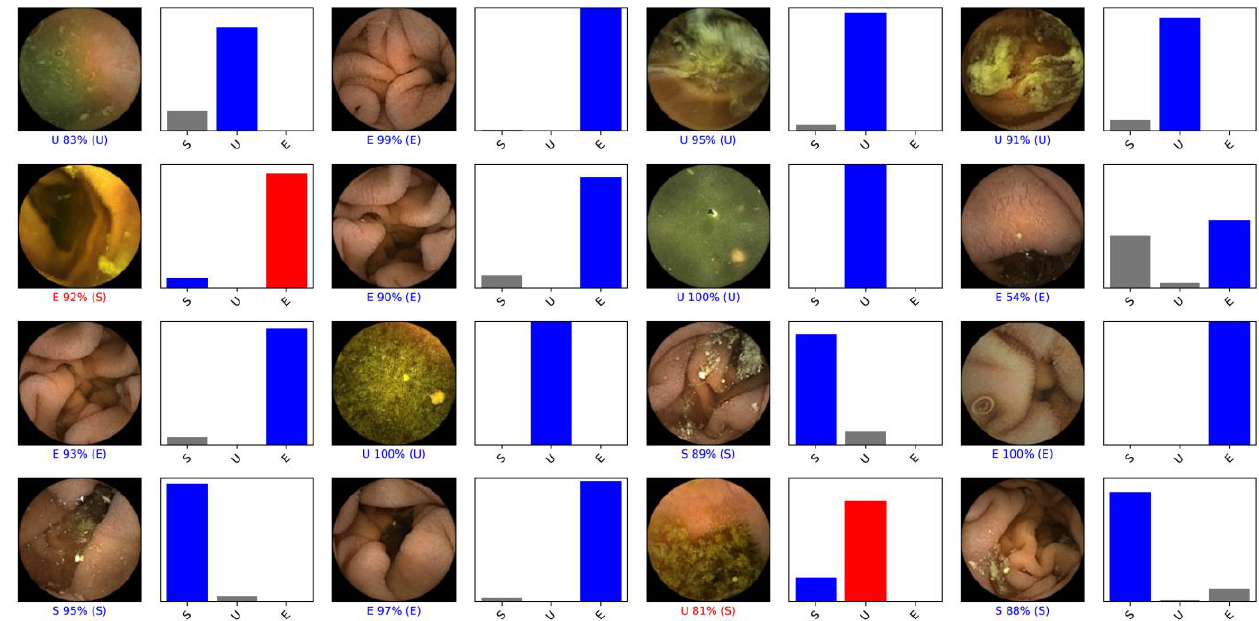
Figure 2. Output obtained by implementing the CNN. The bars represent the probability estimated by the network and the finding with the highest probability was considered to be the predicted classification output. The blue bar represents a correct prediction: E, excellent bowel preparation ( ≥ 90% of the mucosa visualized); S, satisfactory bowel preparation (50–90% of the mucosa visualized); U, unsatisfactory bowel preparation (<50% of the mucosa